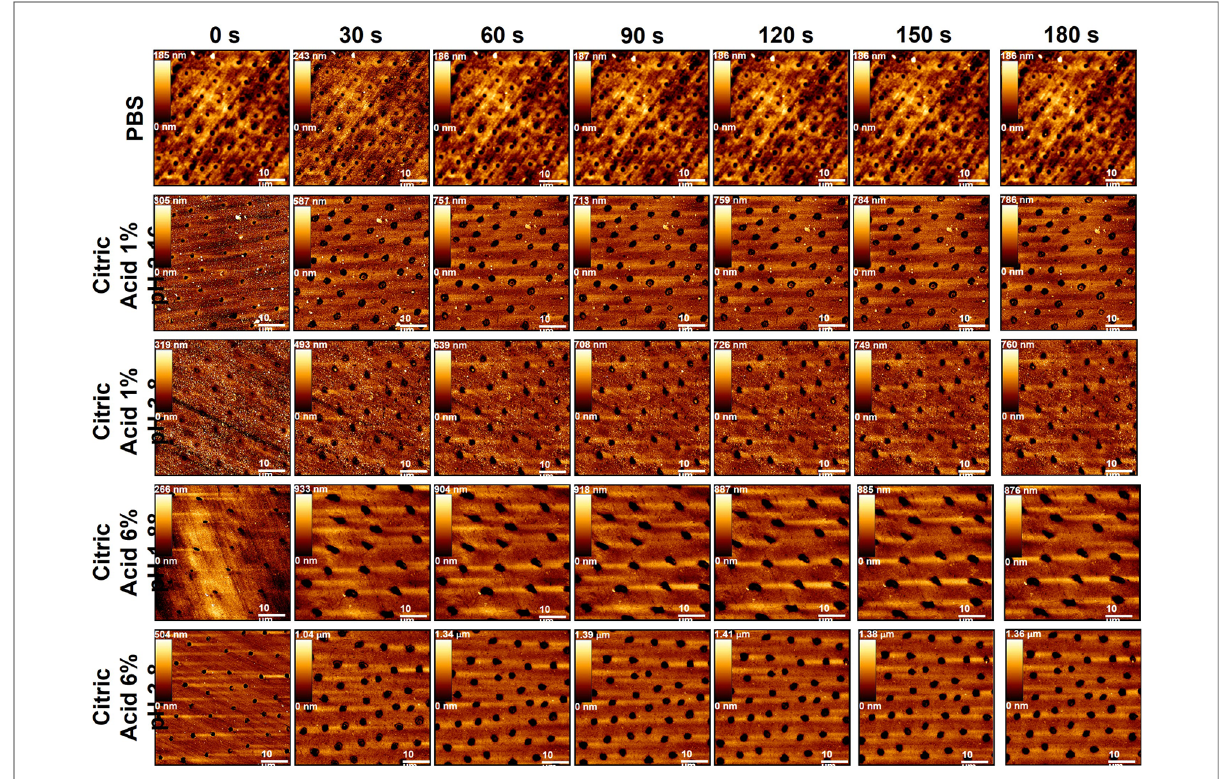
FIGURE 3 Showing example topographic AFM imaging of human dentine exposed to all dietary solutions (top) throughout the exposure regime starting from 0 s (top) to 180 s (bottom) at 30 s